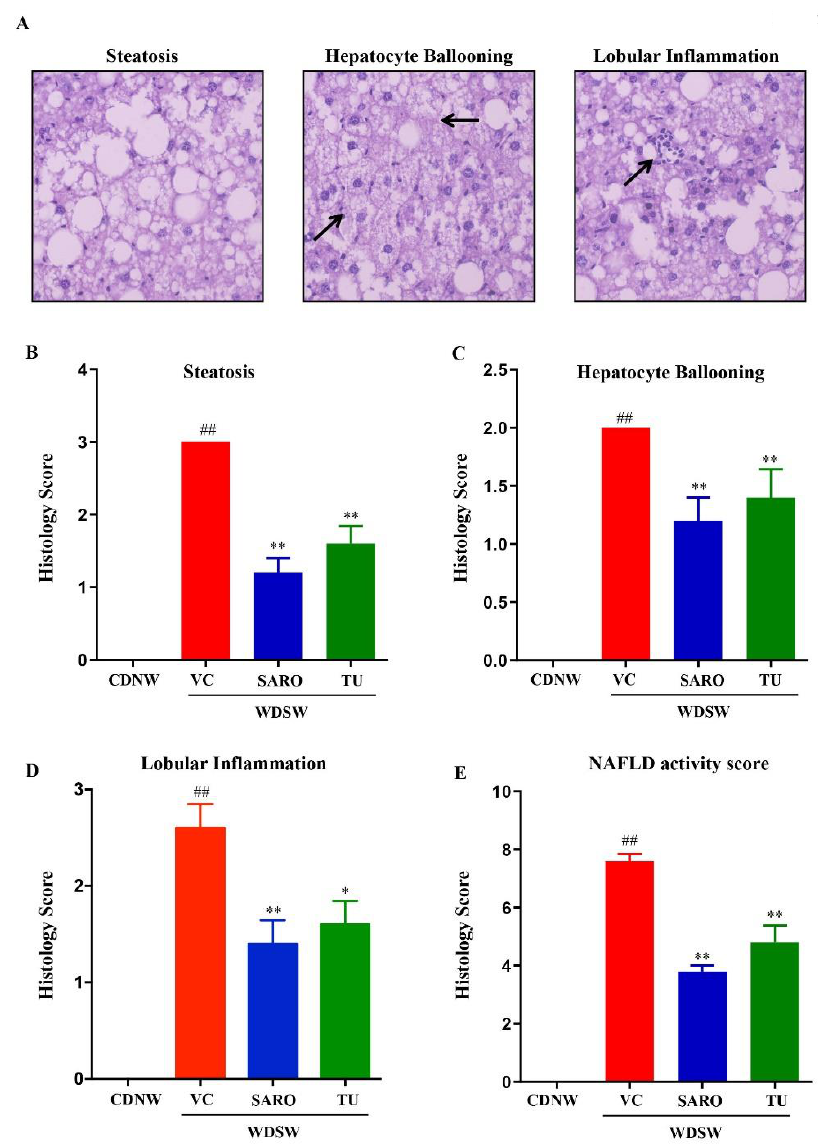
Figure 5. Tecomella undulata ( TU ) treatment ameliorates fatty liver and steatohepatitis. CDNW or WDSW mice treated with vehicle control (VC), saroglitazar (SARO) or Tecomella undulata (TU) for 12 weeks. ( A ) hematoxylin and eosin (H&E) stained liver sections depicting steatosis, hepatocyte ballooning, and lobular inflammation. Histology score for ( B ) steatosis, ( C ) hepatocyte ballooning, ( D ) lobular inflammation, ( E ) NAFLD activity score were quantified. Data are expressed as the mean with SEM for 8 – 10 mice per group. ## p < 0.001 compared to CDNW; ** p < 0.001 or * p < 0.05 compared to WDSW, vehicle control.